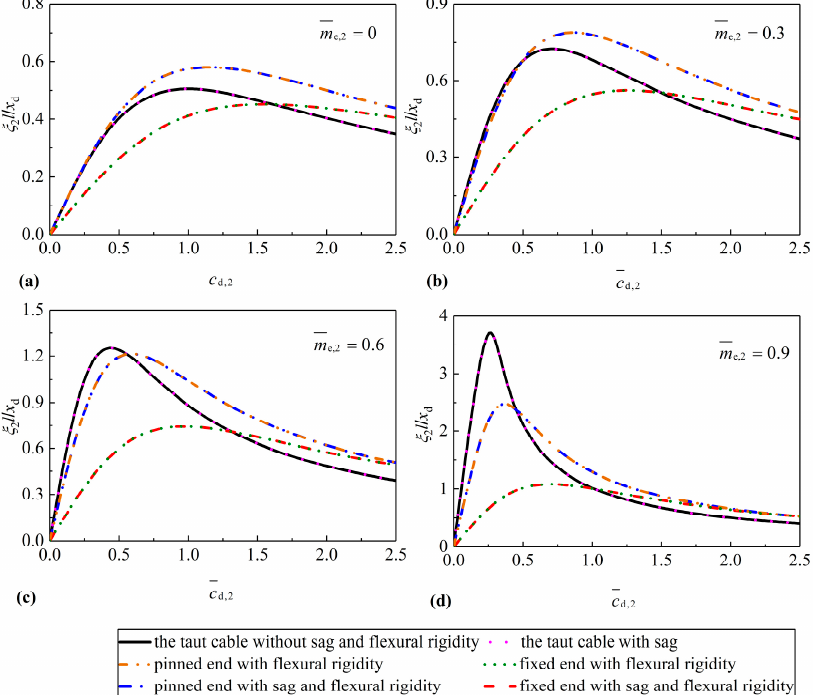
Figure 9. The second supplemental modal damping ratio of the medium cable versus damping coefficient for various inertial masses: ( a ) m e,2 = 0; ( b ) m e,2 = 0.3; ( c ) m e,2 = 0.6; ( d ) m e,2 = 0.9.